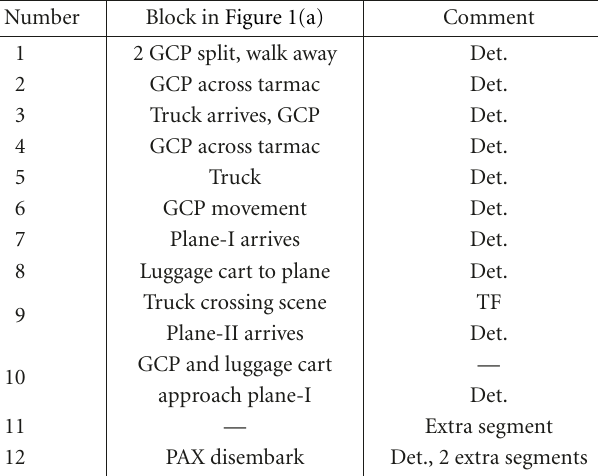
Table 3: TSA dataset: temporal segmentation of two blocks using the online BMS model. GCP = ground crew personnel, PAX = pas- sengers, Det. = segment detected.